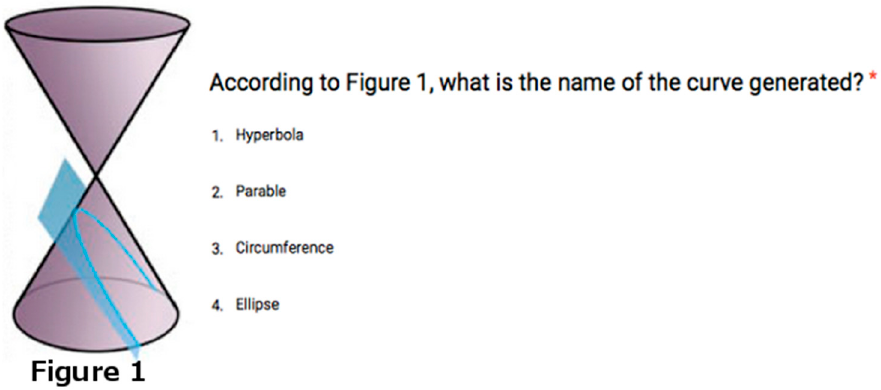
Figure 9. An example of question of the activity 2.